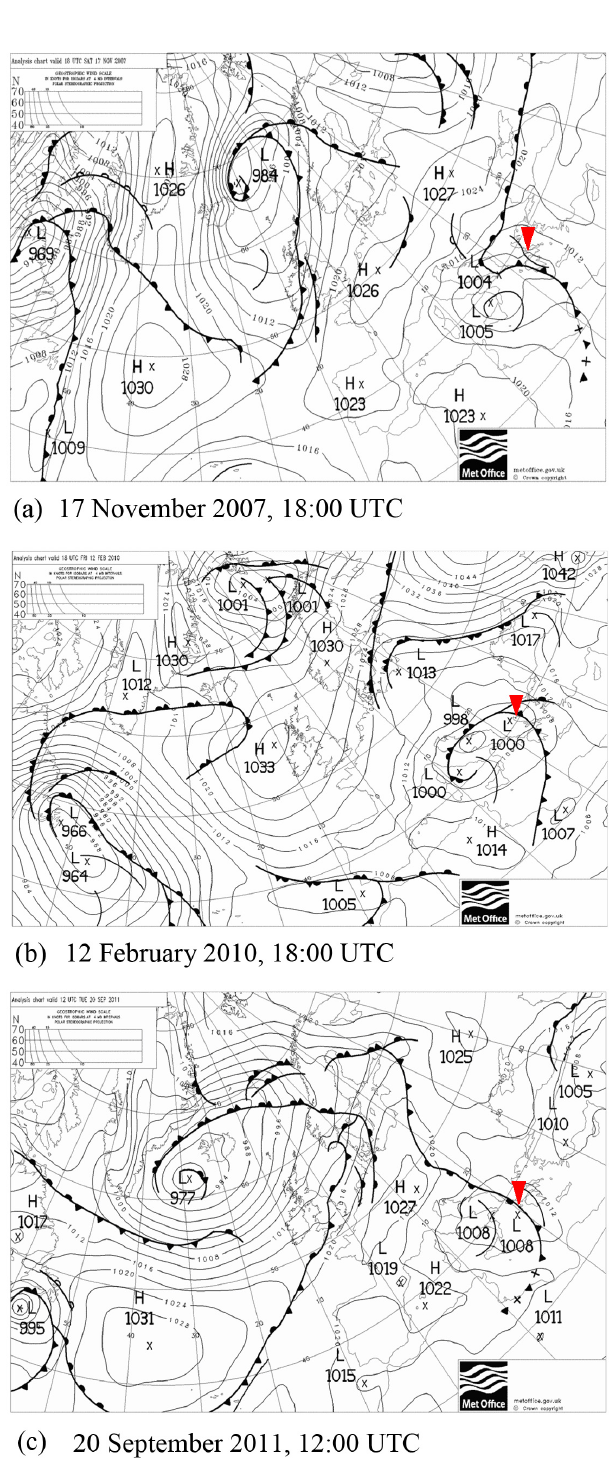
Figure 3. Mean sea level analysis charts, from the UK Met Office, depicting the frontal activity around the tornadoes’ time of occur- rence for T07 (a) , T10 (b) and T11 (c) tornado events. In every image, red triangles indicate the tornado